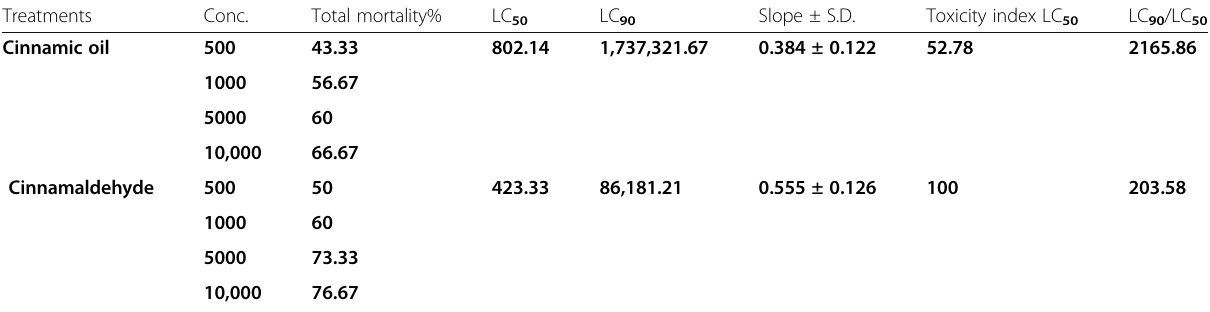
Table 1 Efficiency of cinnamon oil and cinnamaldehyde against Phenacoccus solenopsis under laboratory conditions 27 ± 2 °C and 65 ± 5% RH